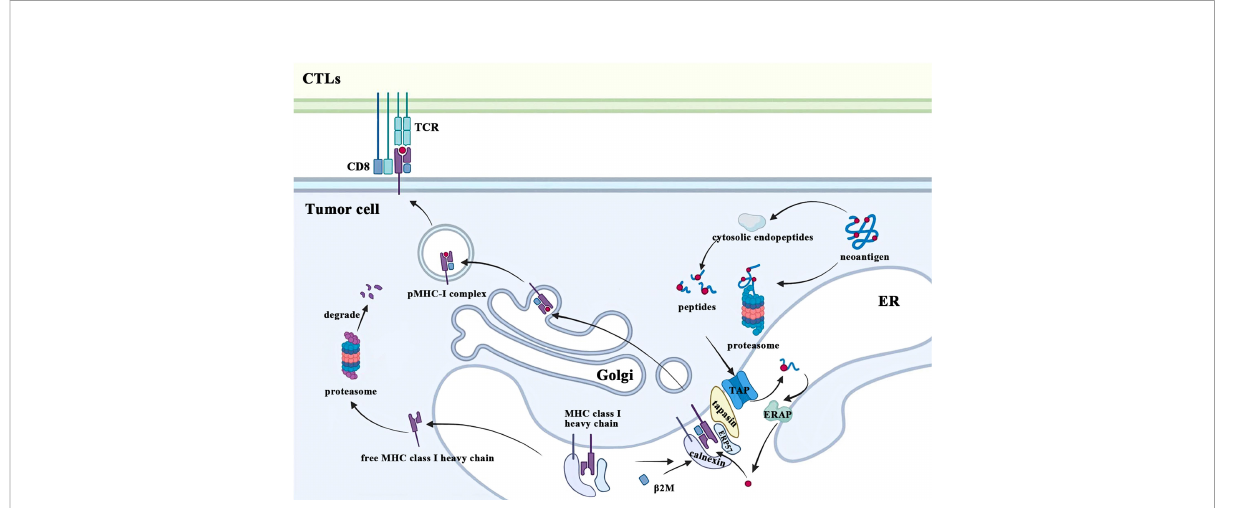
antigen processing; ERAP: endoplasmic reticulum aminopeptidases; ERP57, endoplasmic reticulum resident protein